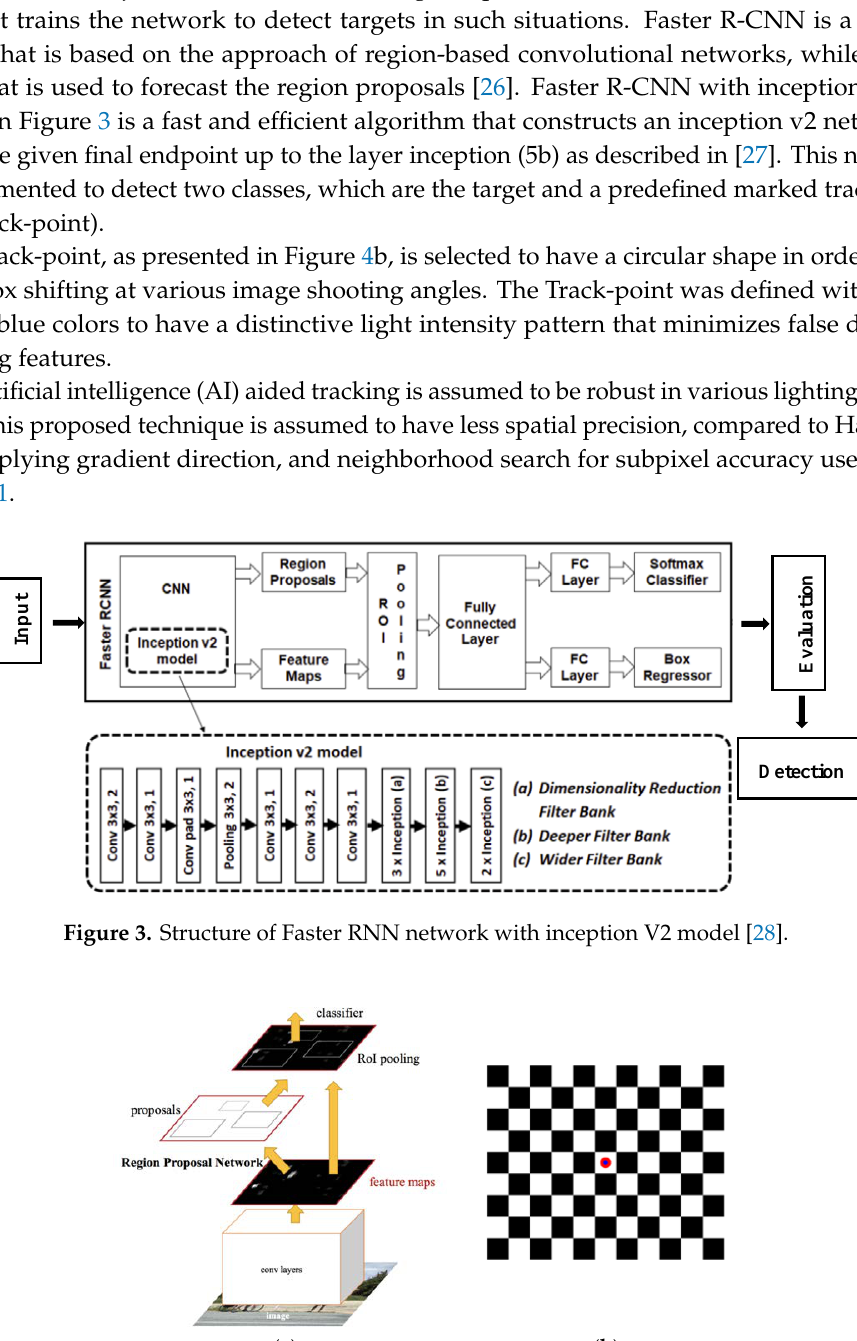
Figure 4. ( a ) Architecture of Faster Region-based convolutional neural networks ( R-CNN) [29], ( b ) Target with Track-point [30].